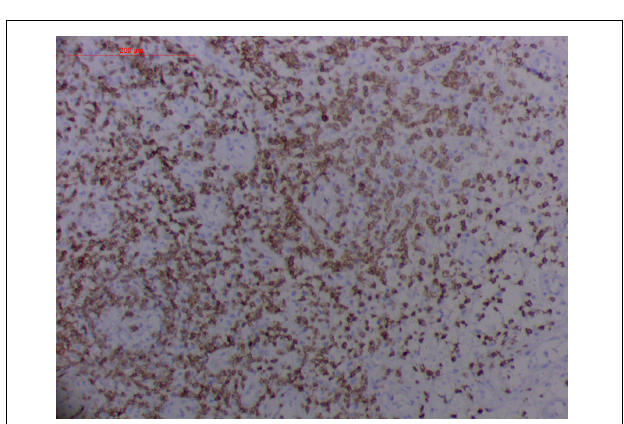
FIGURE 8 | “Extranodal natural killer/T-cell lymphoma, nasal type/rhino-orbital-cerebral mycosis.” Mucor irregularis- induced angioinvasion (H&E, original magnification × 200).